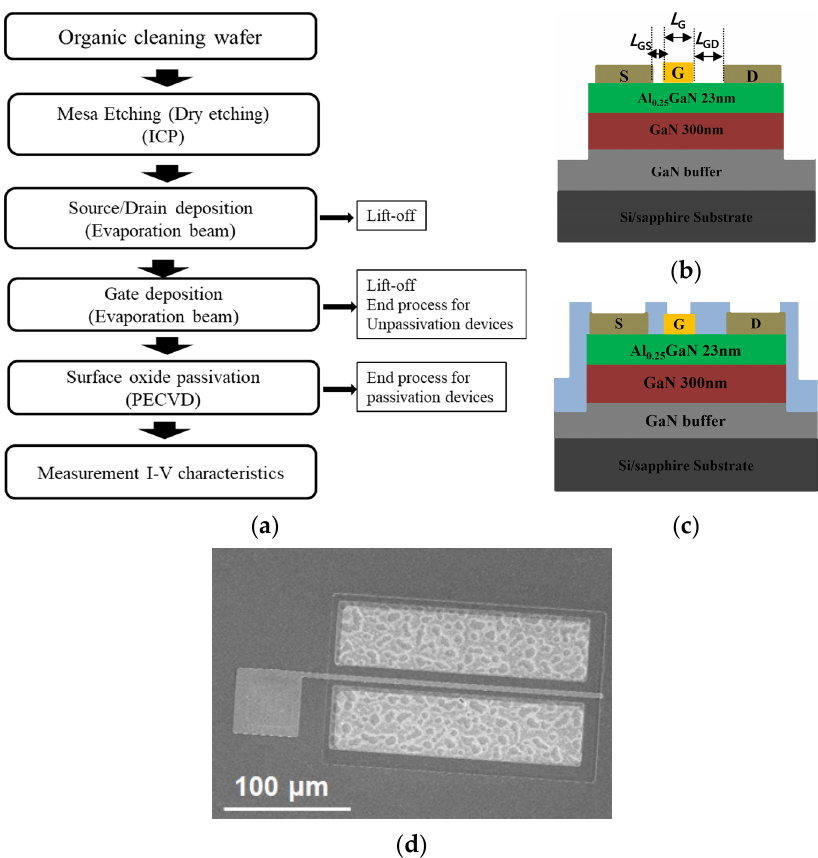
Figure 1. ( a ) Flow chart showing the device fabrication process, schematic of the fabricated AlGaN/GaN HEMTs ( b ) without and ( c ) with SiO 2 passivation, lengths are similar of L G S = 4 μ m, L G = 4.5 μ m, and L GD = 10 μ m, respectively, ( d ) scanning electron microscope image of the fabricated AlGaN/GaN HEMT structure.